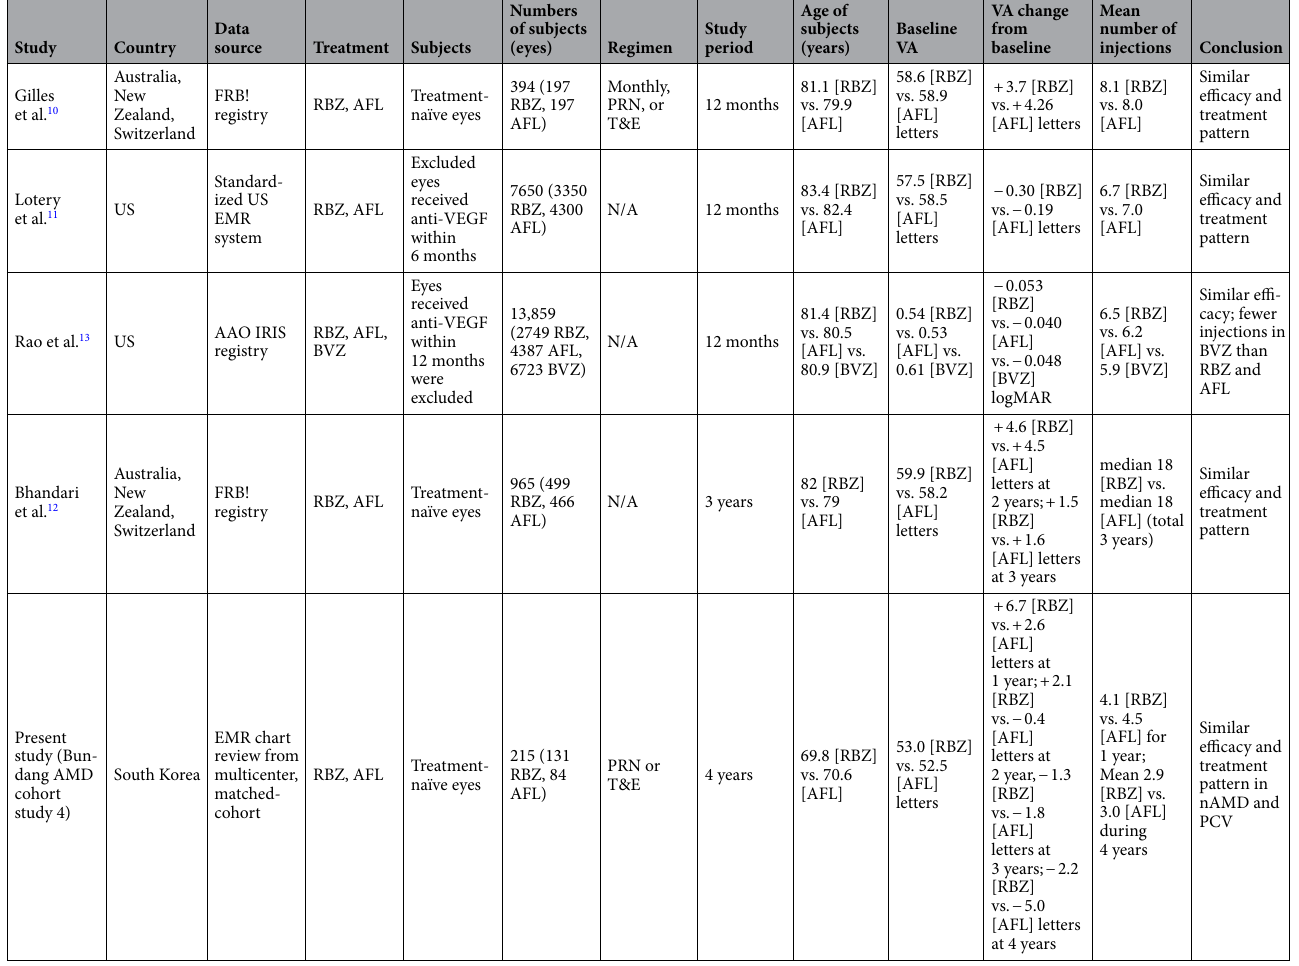
Table 4. Comparison of published real-world comparative studies between ranibizumab and aflibercept. VA visual acuity, EMR electronic medical records, RBZ Ranibizumab, AFL Aflibercept, BV Z Bevacizumab, PRN pro re nata, T&E treatment and extend, LogMAR Log minimum angle of